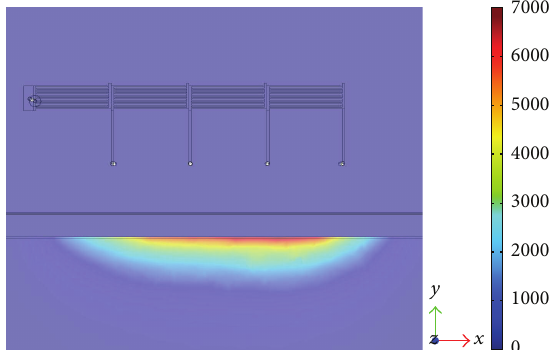
Figure 3: Example of the ZOR MTM applicator consisting of a four- unit cell. Figure 4: Top view of the applicator, water bolus, and the tissue to